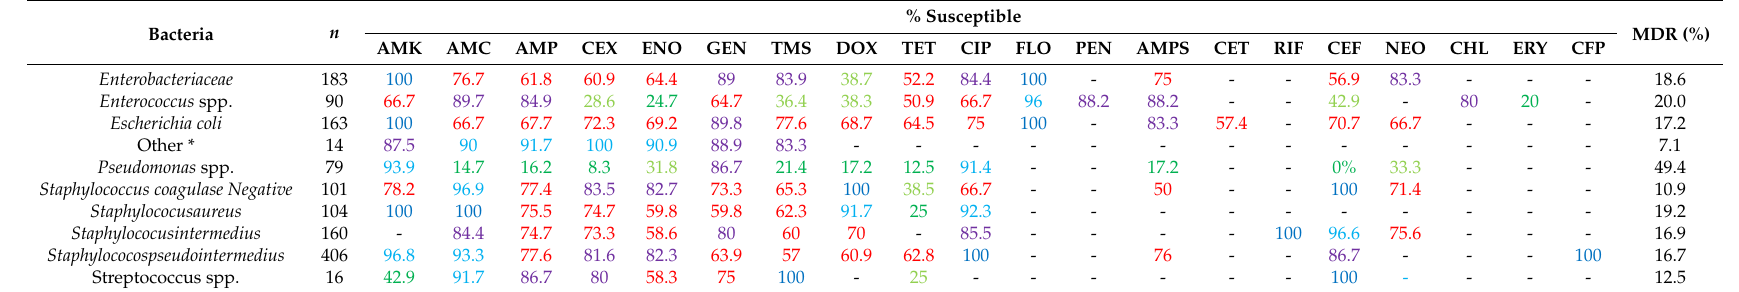
Table 2. Antibacterial susceptibilities in bacteria isolated from clinical samples of dogs (2016–2019).